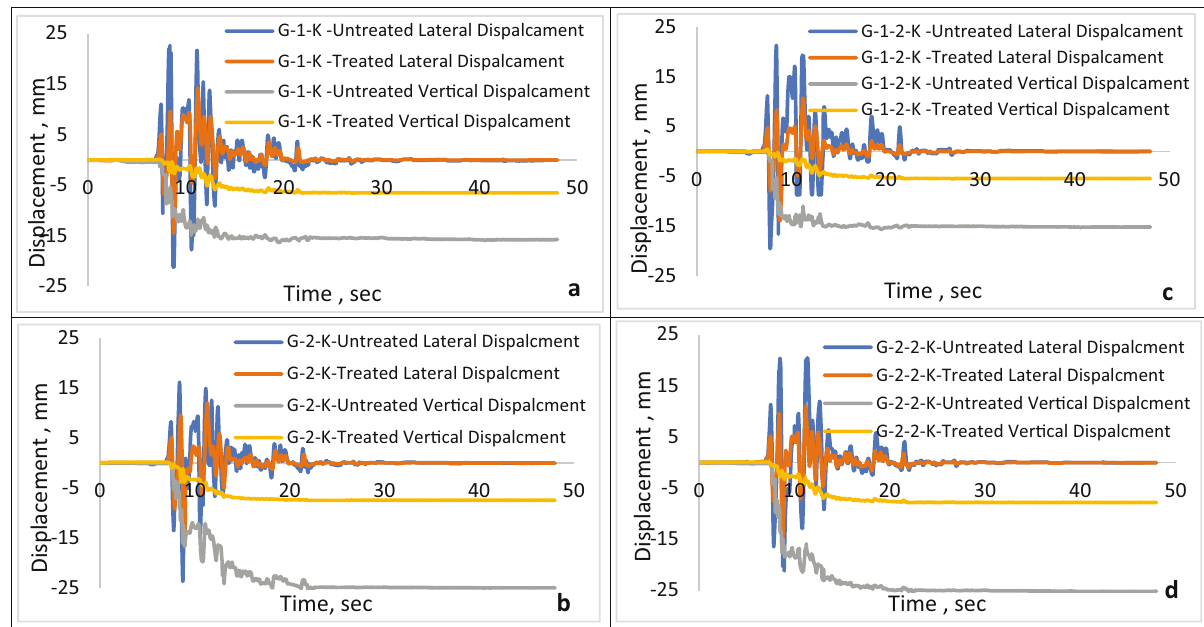
the pile in the untreated layer.